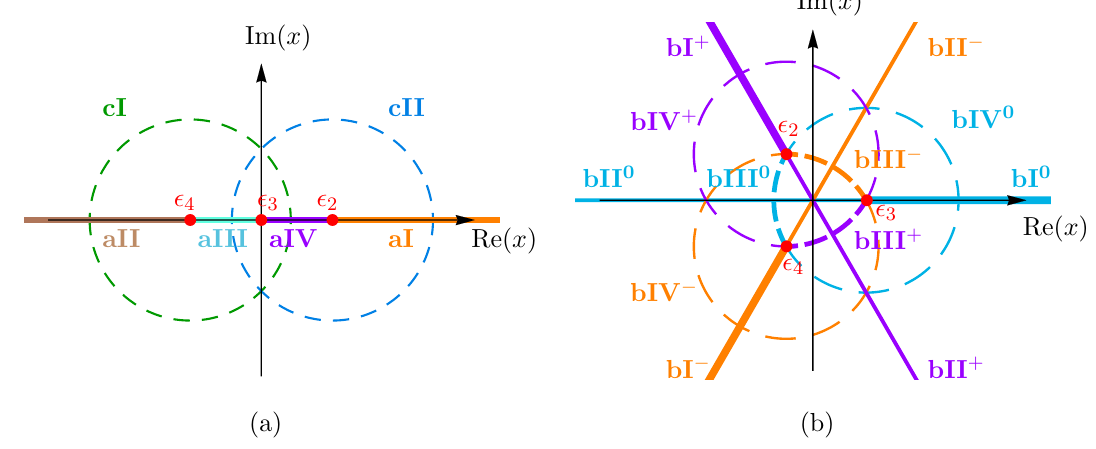
Figure 2 . Graphic representation of Lag lines on an elliptic curve embedded in P 2 to a square untilted two-torus (a) or a hexagonal two-torus (b). The Lag lines are drawn in the x -plane with v = 1, following the notation in the overview tables 5 and